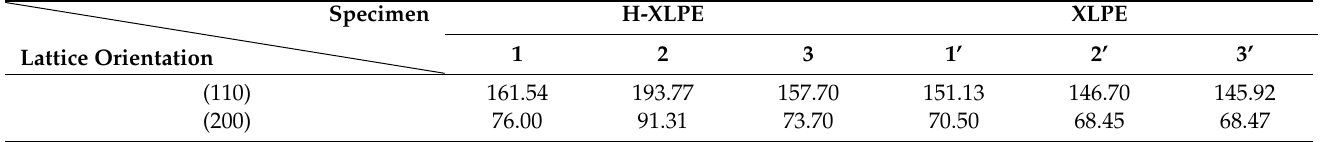
Lattice Orientation